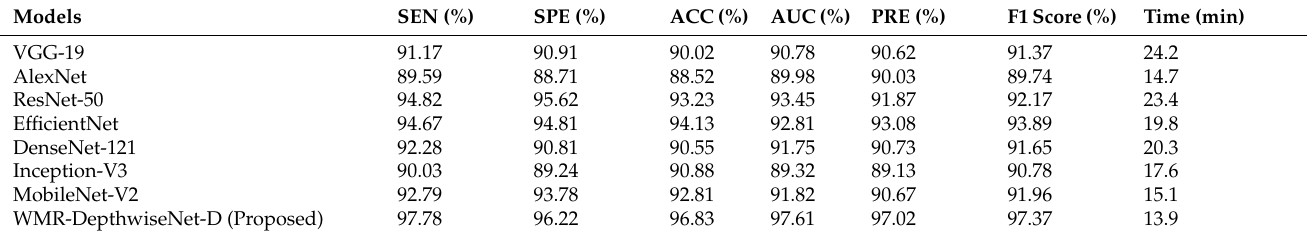
Table 7. Comparing the performance of our formulated WMR-DepthwiseNet with famous pretrained algorithms using the same CT dataset. We only fine-tuned the last layer of the pretrained algorithms to match the number of